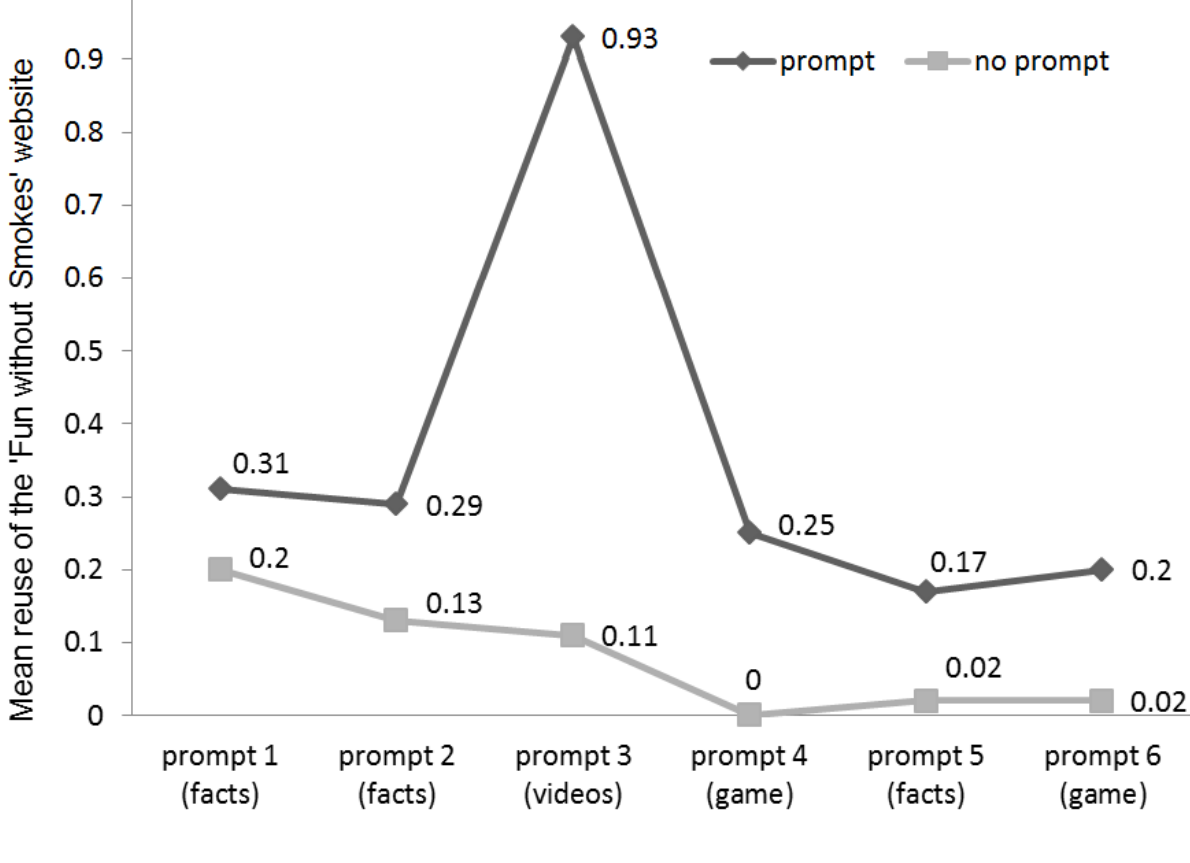
Figure 2. Means of reuse of the "Fun without Smokes" website between prompt and no-prompt group. X-axis time points: prompt 1= 1 month; prompt 2= 2 months; prompt 3= 3 months; prompt 4= 5 months; prompt 5= 7 months; prompt 6= 9